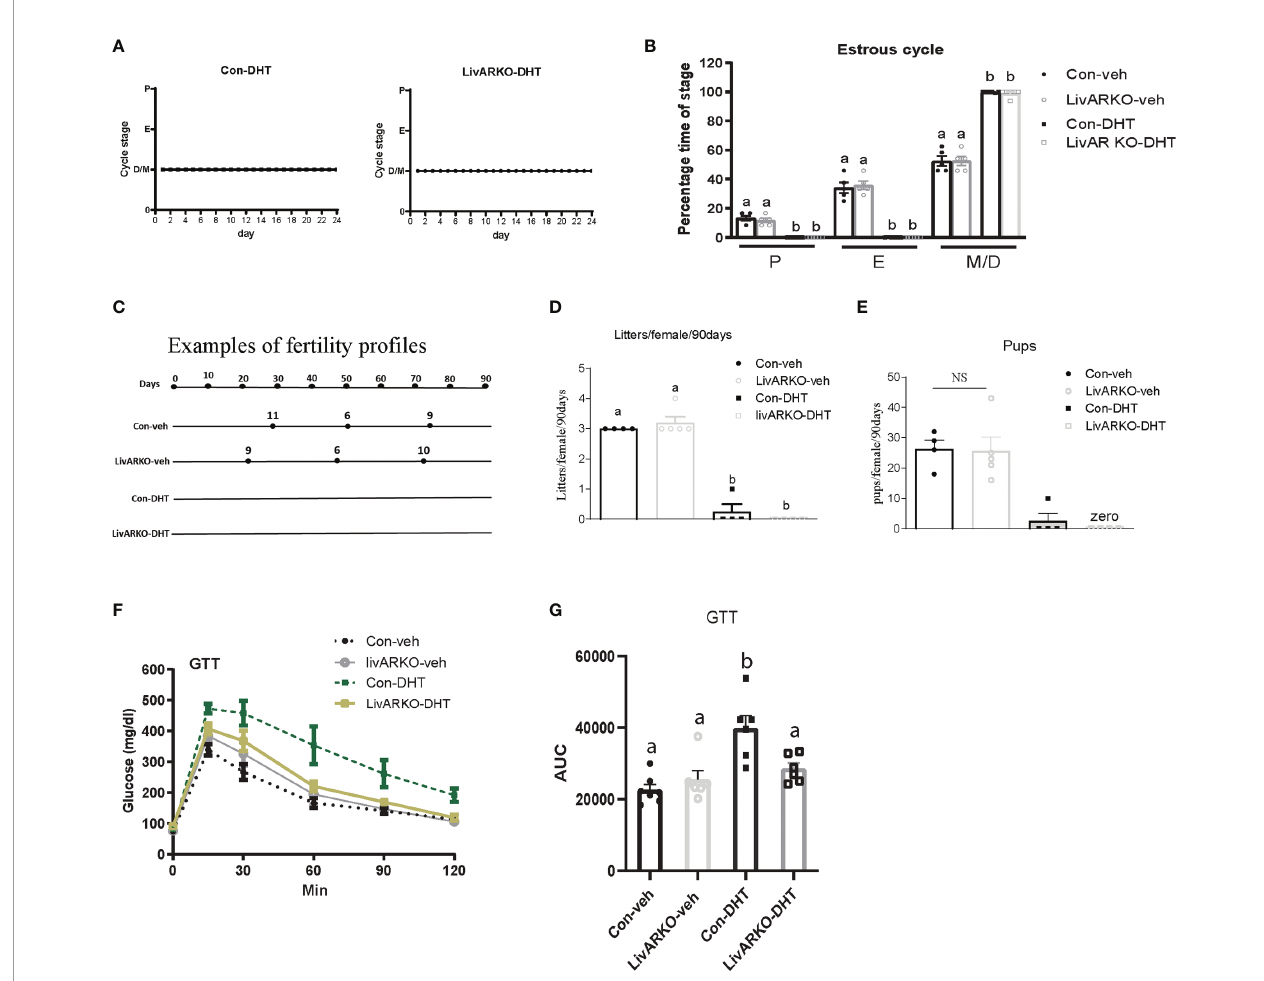
FIGURE 3 | Cyclicity and fertility of mice with DHT treatment. Representative data for vaginal cytology from individual Con-DHT and LivARKO-DHT mice (A) . (B) Estrous cycles. Percentage time spent in each stage of the estrous cycle was signi fi cantly differently among the four groups. Metestrus (M)/diestrus (D) was shown consistently in DHT treated mice. (C) Example offertility pro fi le: female mice were mated with wild type male mice for 90 days. Each line represents an individual female mouse of each group. The black dot represents the day that each litter was born after introduction to male. Number on the top of line represents how many pups in each litter. Total numbers of litters (D) and pups (E) per female were signi fi cantly reduced in DHT treated (Con-DHT and LivARKO-DHT) mice compared to vehicle treated mice during the 90 days of mating. (F) Control and LivARKO mice, with and without DHT treatment were subjected to glucose tolerance test (GTT). (G) The area under the curve (AUC) was determined for the GTT. Statistical analysis was performed using two-way ANOVA followed by Tukey ’ s multiple tests. Bars with different letters represent signi fi cantly different values from each other with p<0.05. Values are mean ± SEM, n =